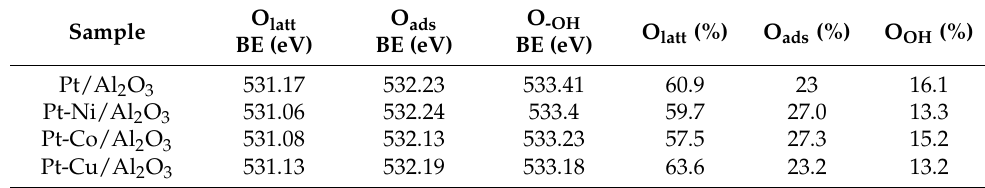
Figure 4. ( a ) Al 2p/Pt 4f and ( b ) O1s XPS spectra of these Pt/Al 2 O 3 and Pt ‐ M/Al 2 O 3 samples. Table 2. The binding energy and percentage ratio of O 1s XPS results over these Pt-based samples.